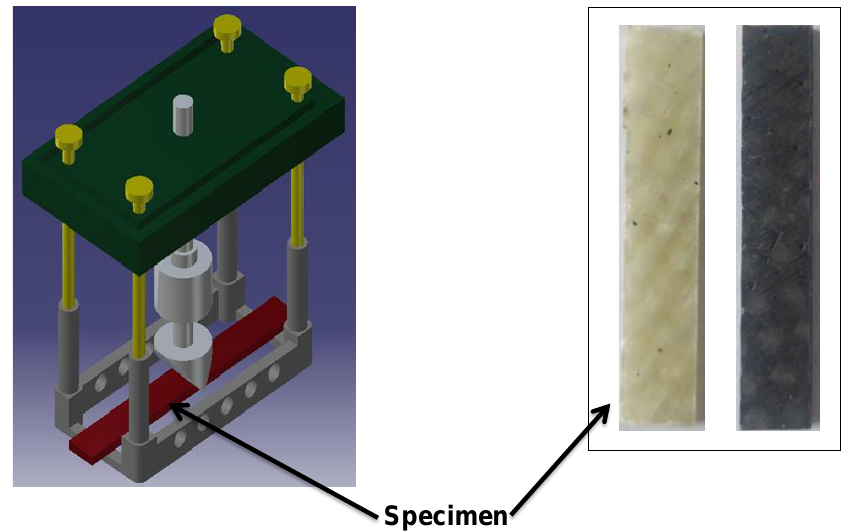
Figure 2. Three-point bending fixture with rectangular specimens of glass / epoxy and carbon / epoxy composites.